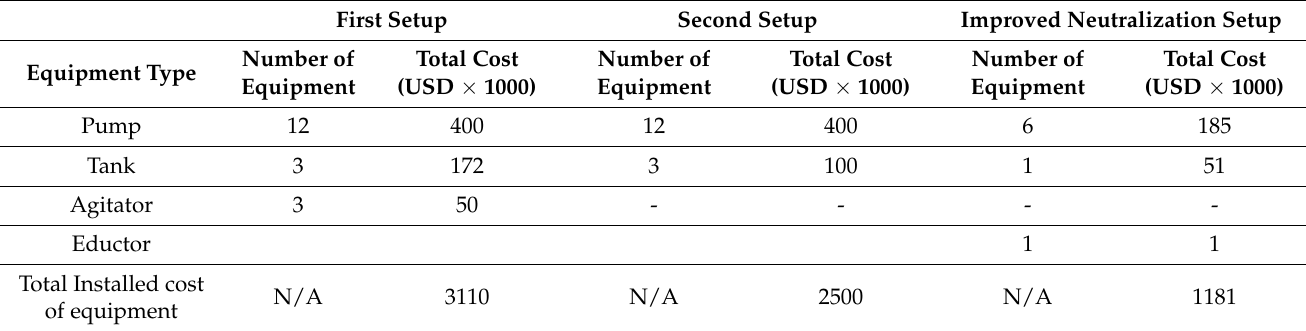
Table 2. Comparison of equipment cost and number of equipment for different neutralization